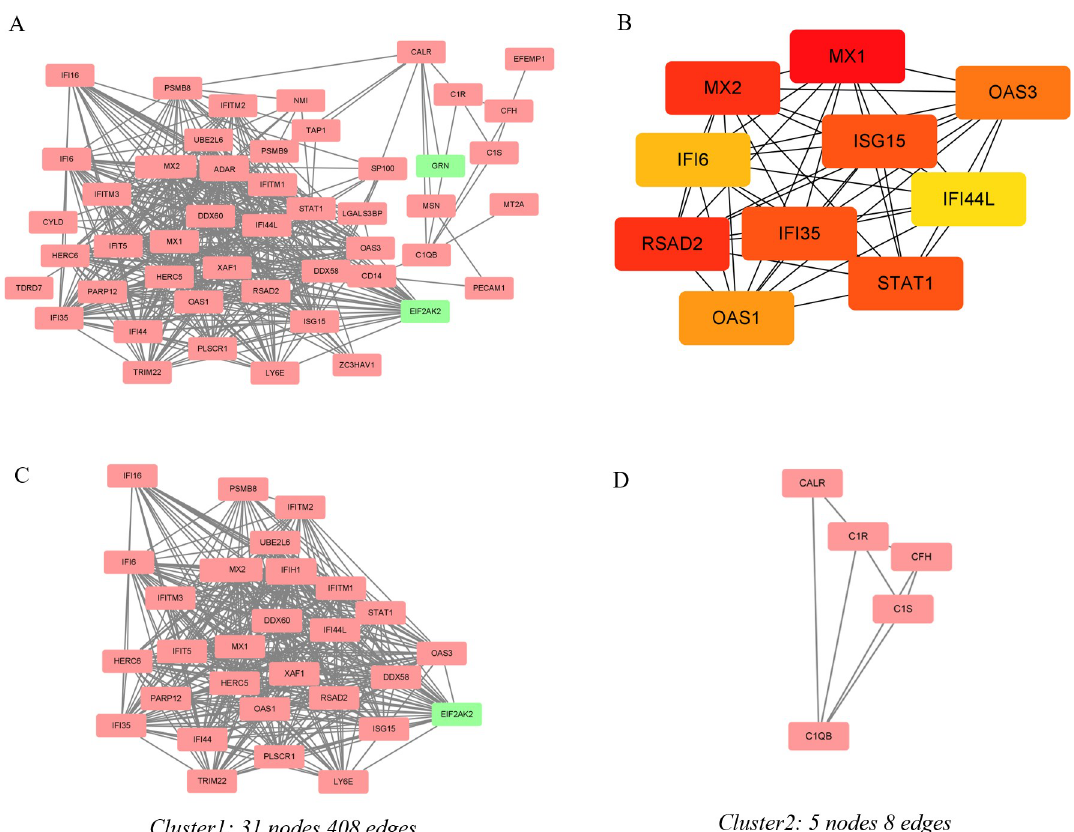
Fig 4. PPI network of DEGs and two cluster modules extracted by MCODE. (A) The interaction network among proteins coded by DEGs. Each node represents a protein, whereas each edge represents one protein–protein association. The red rectangles represent the upregulated gene, and the green ones represent the downregulated gene. (B) A network of the top 10 hub genes from the PPI network. Node color reflects the degree of connectivity. Red represents a higher degree, and yellow represents a lower degree. Two cluster modules extracted by MCODE. Cluster 1(C) had the highest cluster score (MCODE score = 27.2), followed by cluster 2 (D) (MCODE score =